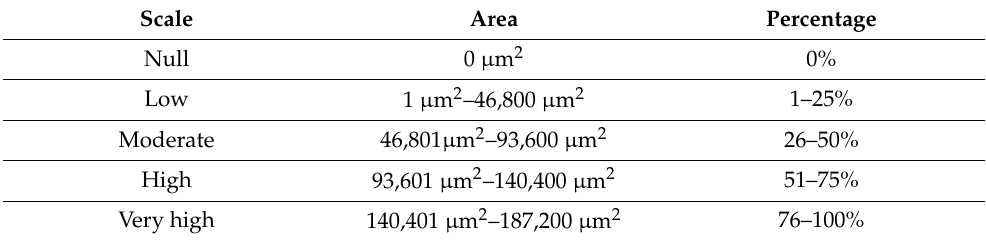
Table 1. Fluorescence scale on performed